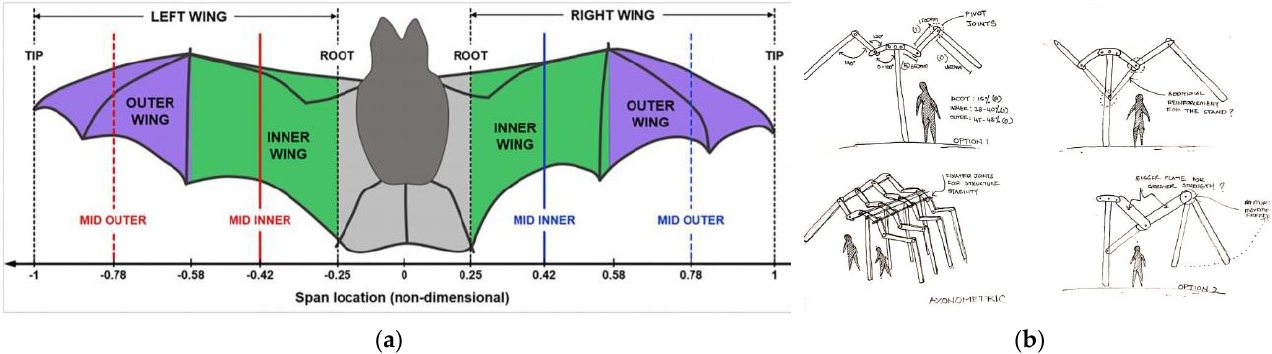
Figure 4. ( a ) The structural organization of a bat wing [25]. ( b ) A conceptual sketch mimicking bat wings. Photos: [26].